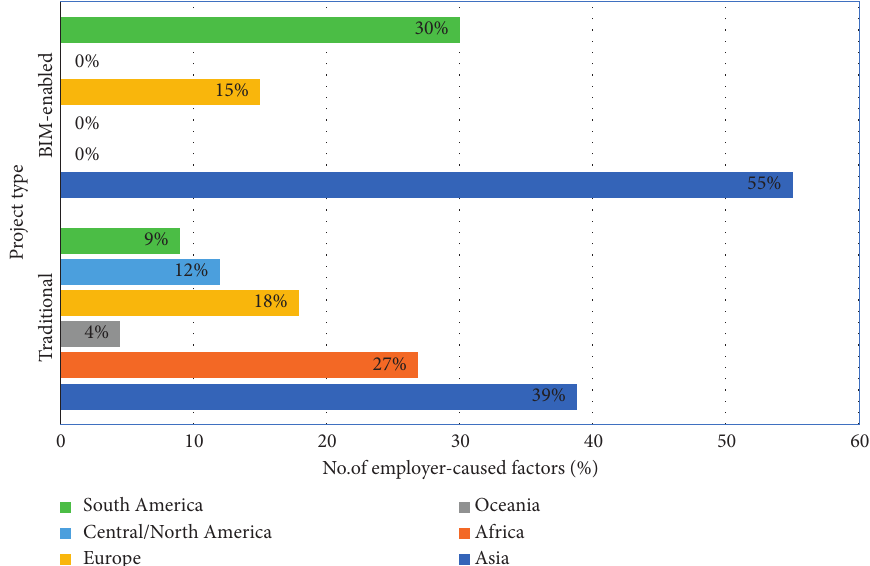
Figure 4: Percentage of employer-caused factors for traditional and BIM-enabled projects in different